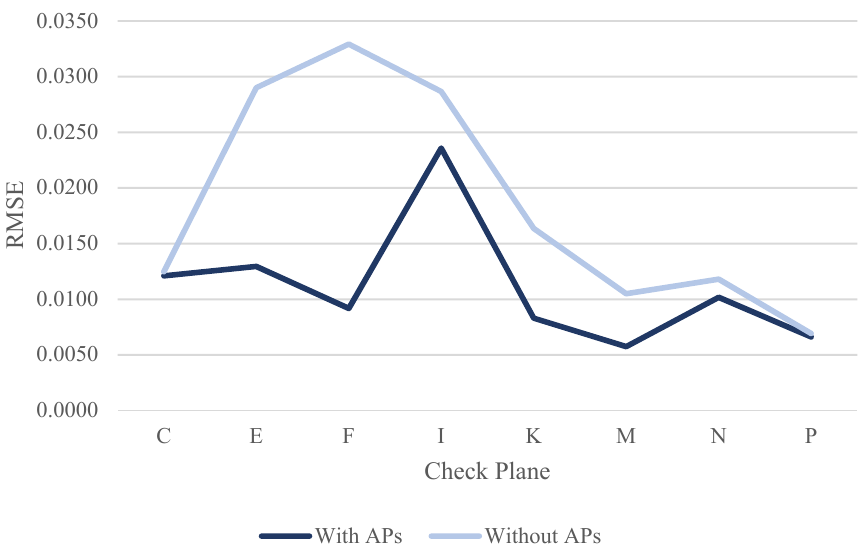
Figure 25. The line chart of RMSE for check planes in dataset DATA1.